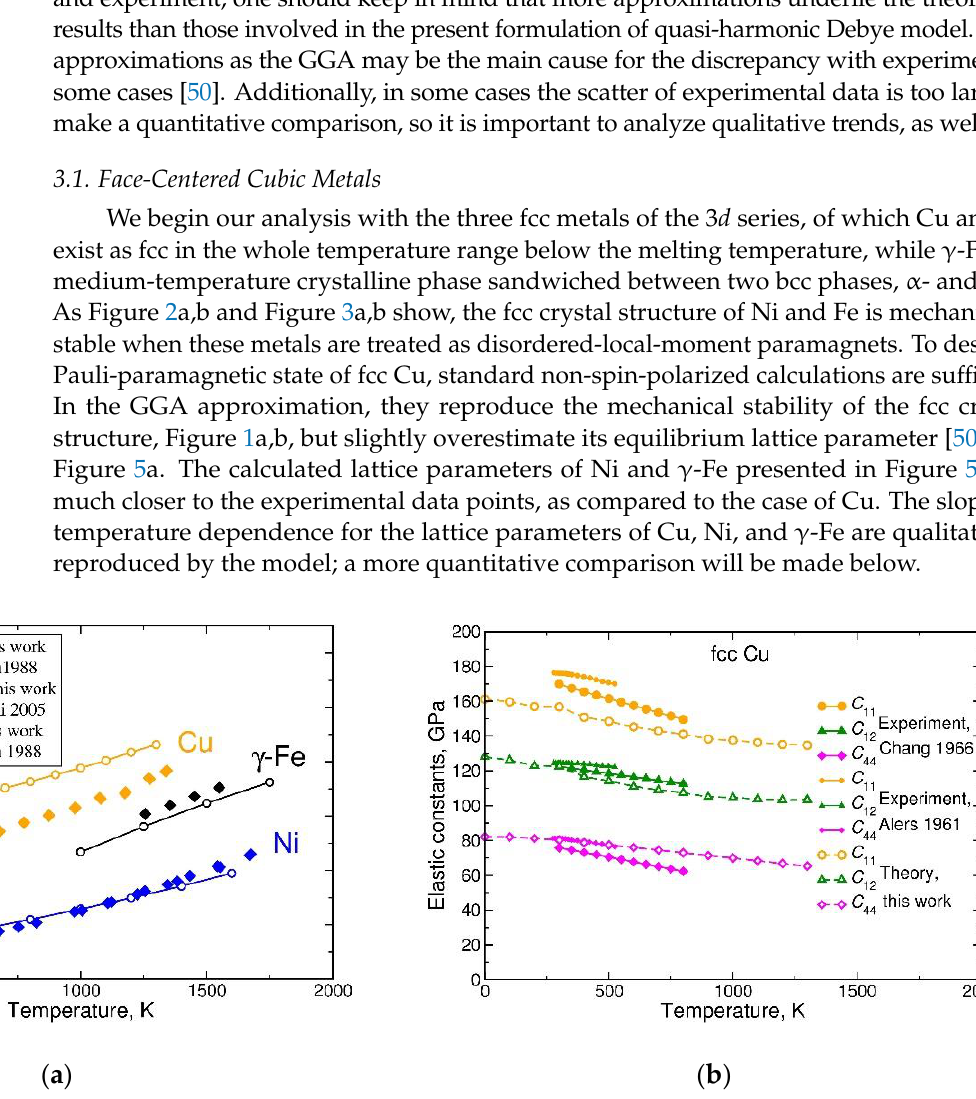
Figure 5. Thermodynamic properties of selected fcc metals derived from the Helmholtz free energy: ( a ) lattice parameters of Cu, Fe, and Ni in comparison with experimental data of References [51,52]; ( b ) cubic elastic constants of Cu in comparison with experimental data of References [53,54]. Open symbols represent results from present work and solid symbols are experimental data.